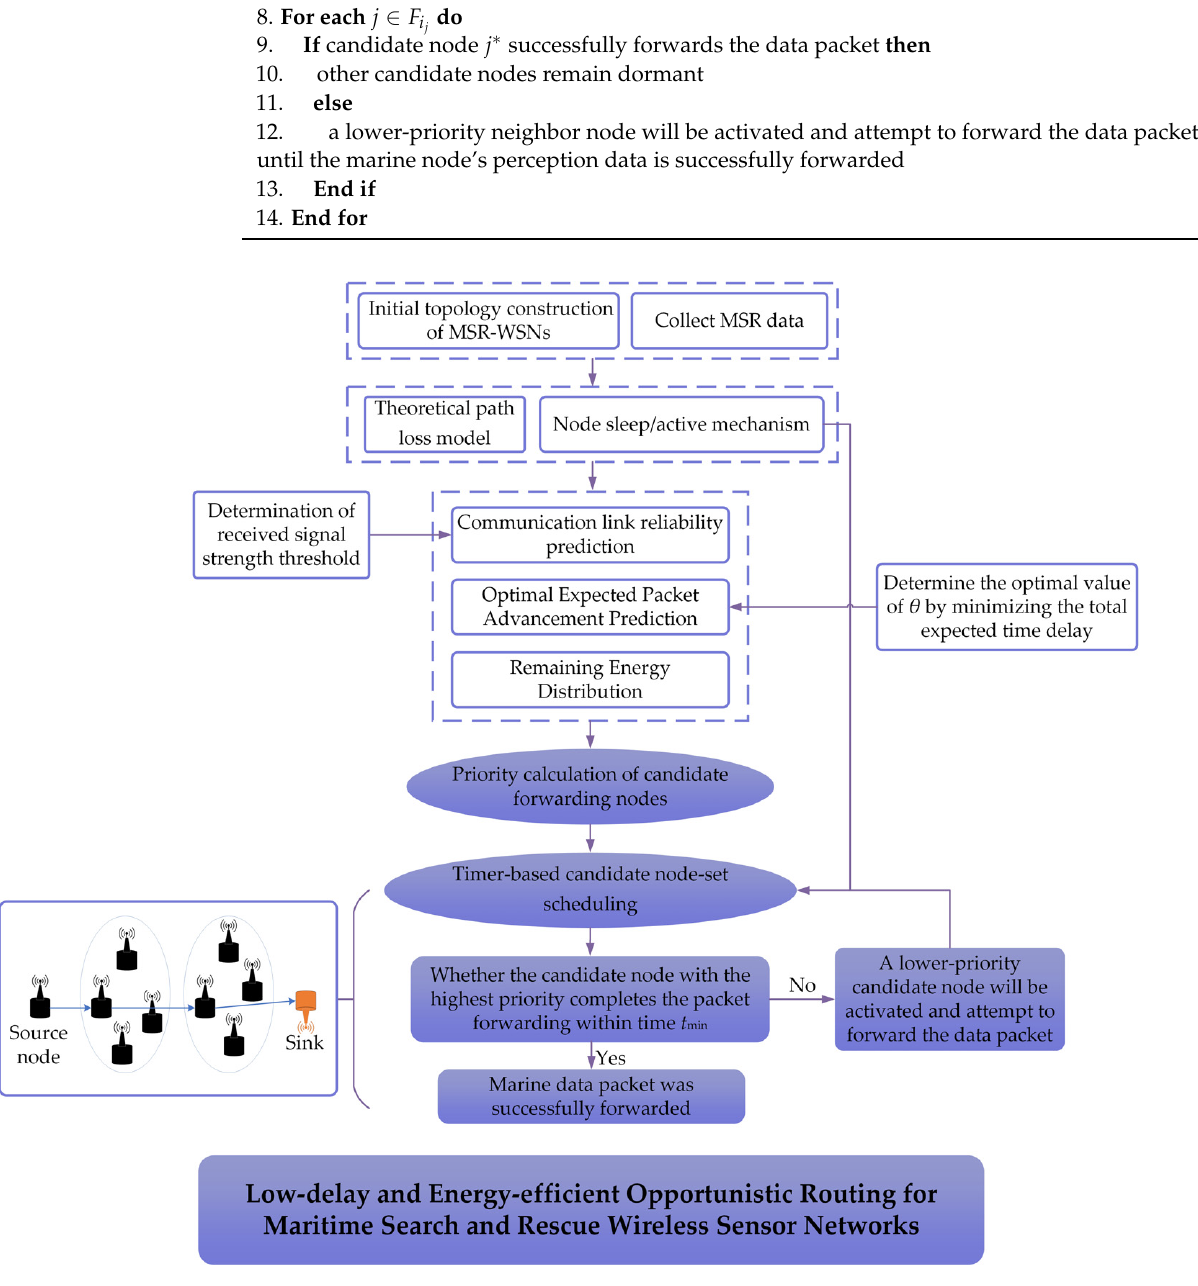
Figure 3. The flowchart of the proposed opportunistic routing algorithm.